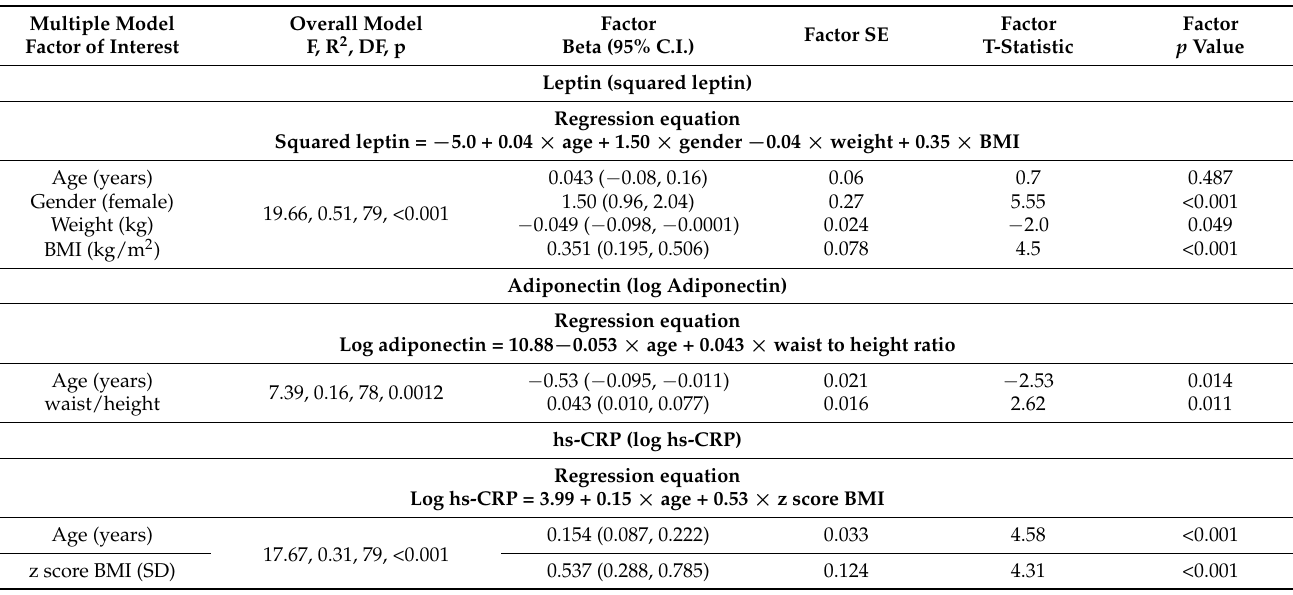
Table 8. Multiple regression models of leptin, adiponectin, and CRP, after applying the forward stepwise method for variable insertion and evaluation with demographic and anthropometric